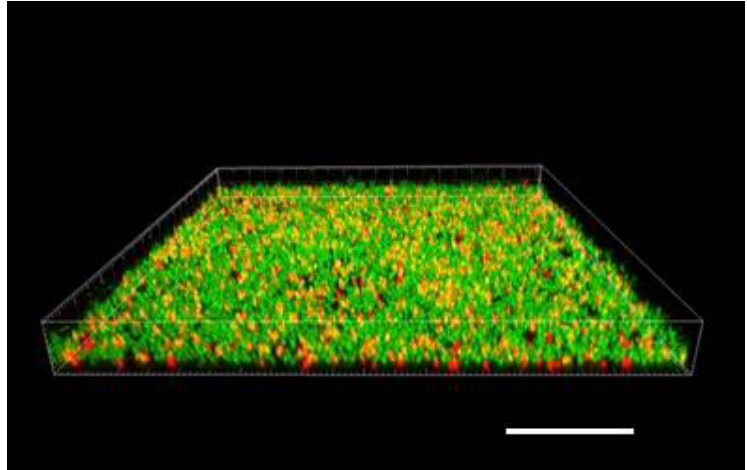
Figure 2. Three-dimensional rendering of a biofilm layer of S. epidermidis cells created from a confocal stack using Imaris software (Bitplane United States, Concord, MA). Side of the square frame 101.6 μm; height (z-dimension = focus range) 9.4 μm; scale bar applies to the front lower edge = 20 μm. Composite image of two emission bands (same as Figure 1).